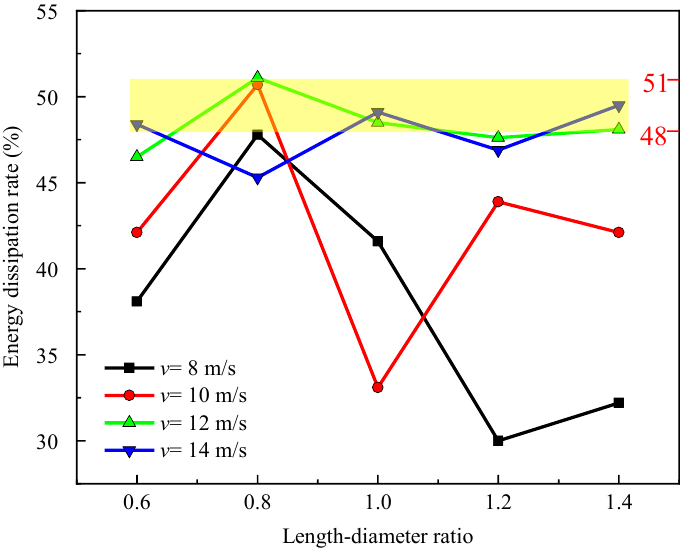
Figure 8. Energy dissipation rate with different impact loading.